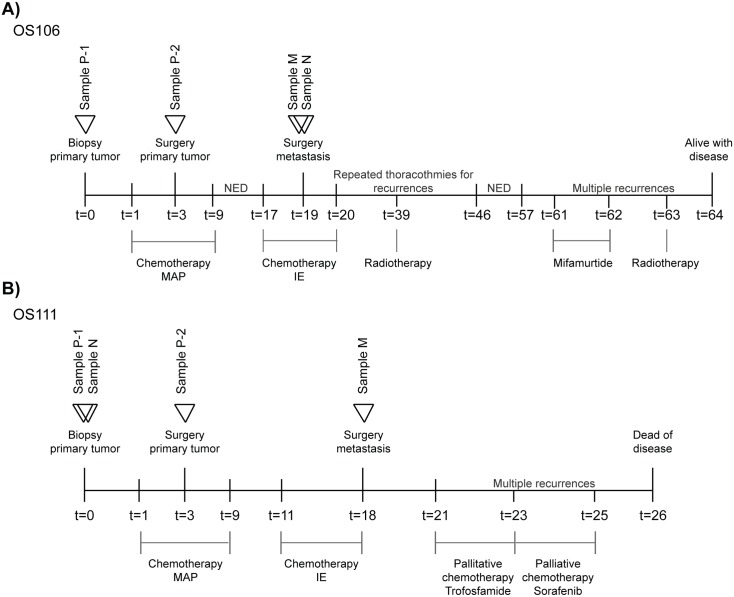
Schematic timeline of the disease and treatment courses of the two patients for (A): OS106 and (B): OS111.Time is shown in months. P-1: primary tumor treatment naïve, P-2: primary tumor treatment experienced. N: normal, M: metastasis, MAP: methotrexate, doxorubicin and cisplatin, IE: ifosfamide and etoposide, NED: No evidence of disease.